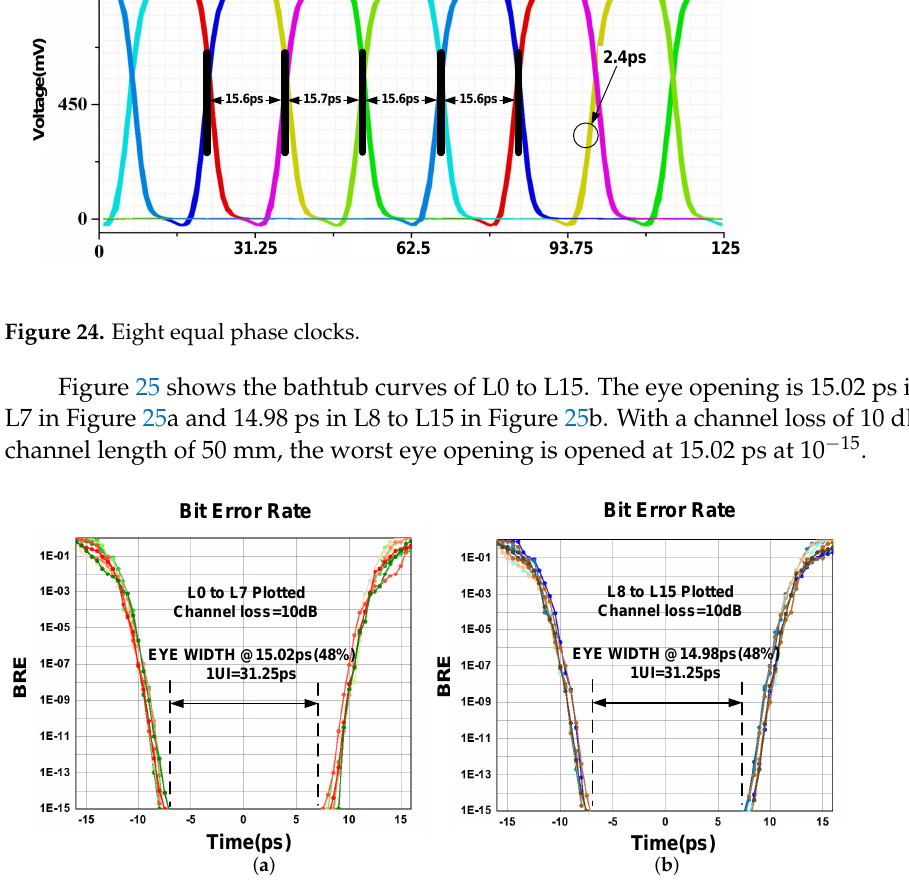
Figure 25. Measured bathtub diagrams showing the eye opening at 10 − 15 . ( a ) bathtub curves of L0 to L7, ( b ) bathtub curves of L8 to